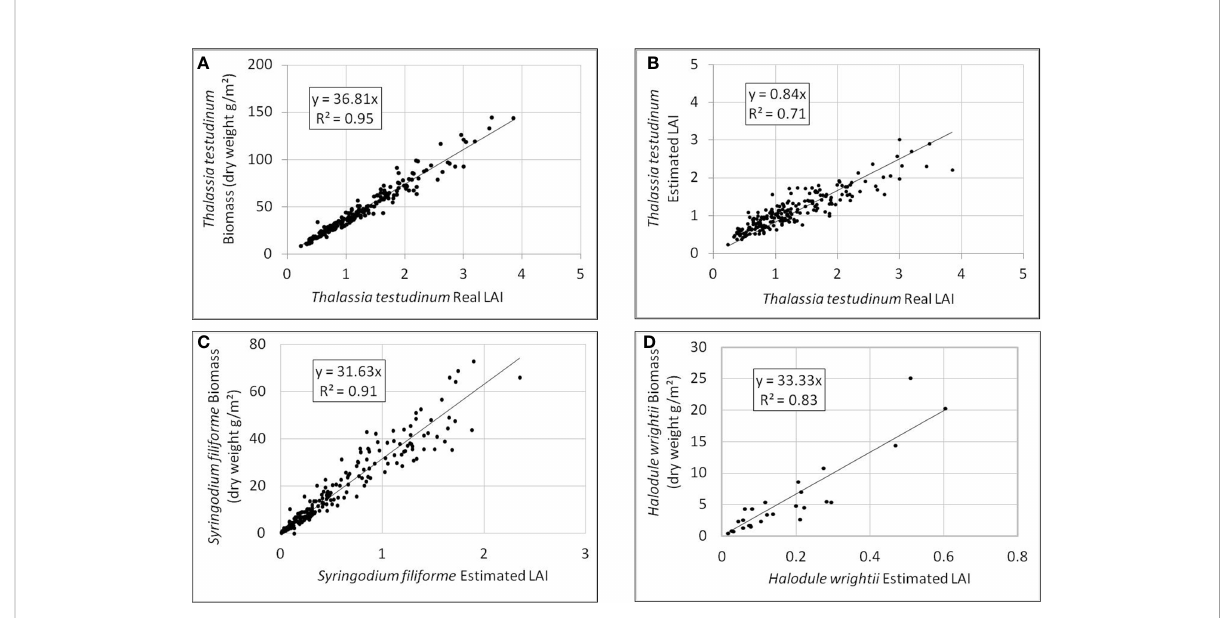
FIGURE 3 Relationships to verify the estimation of LAI. For Thalassia testudinum data ( n data = 206) (A) real LAI vs above-ground biomass; (B) real LAI vs estimated LAI (using fi xed values of leaf width (0.94 cm) and number of leaves/shoot (1.89). For the other species, relationship between estimated LAI and above-ground biomass for: (C) Syringodium fi liforme ( n data = 215); (D) Halodule wrightii ( n data =